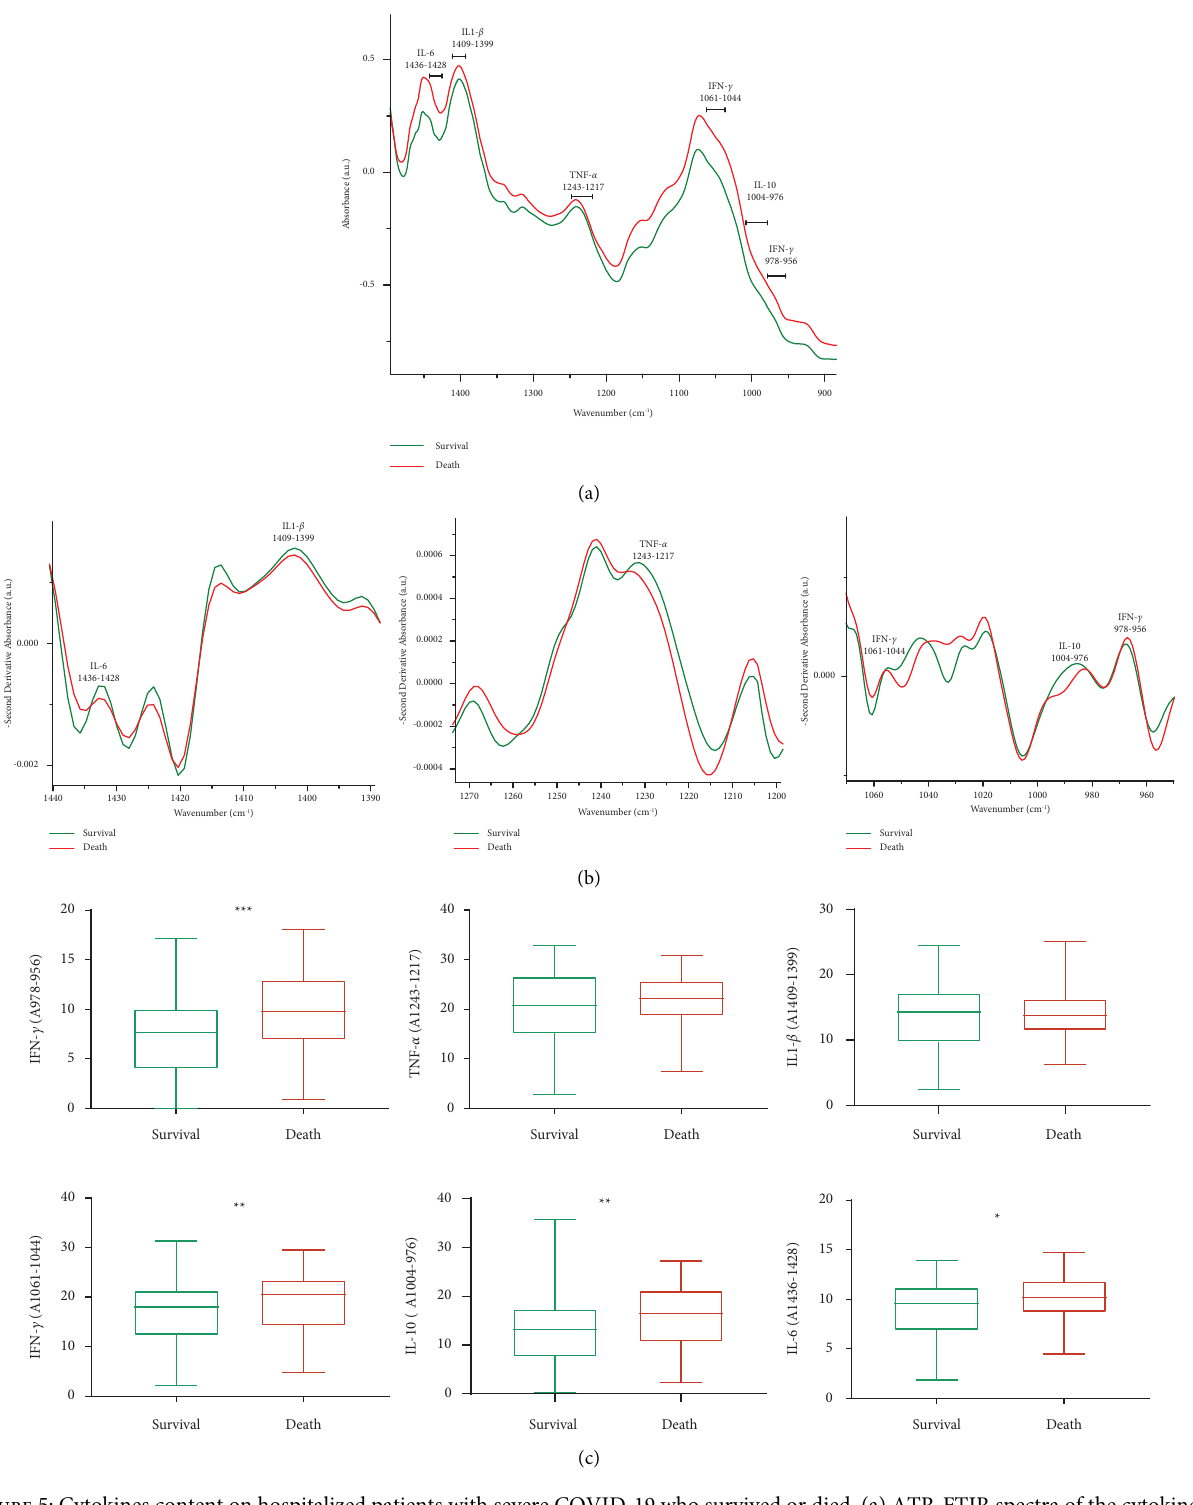
Figure 5: Cytokines content on hospitalized patients with severe COVID-19 who survived or died. (a) ATR-FTIR spectra of the cytokine’s regions. (b) Second derivative of the ATR-FTIR spectra of the analyzed cytokines. (c) IFN- c , TNF- α , IL1- β , IlL-10, and IL-6 (median and RIQ) levels. U-Mann–Whitney analysis. ∗ p < 0 . 05 , ∗∗ p < 0 . 005, ∗∗∗ p < 0 .